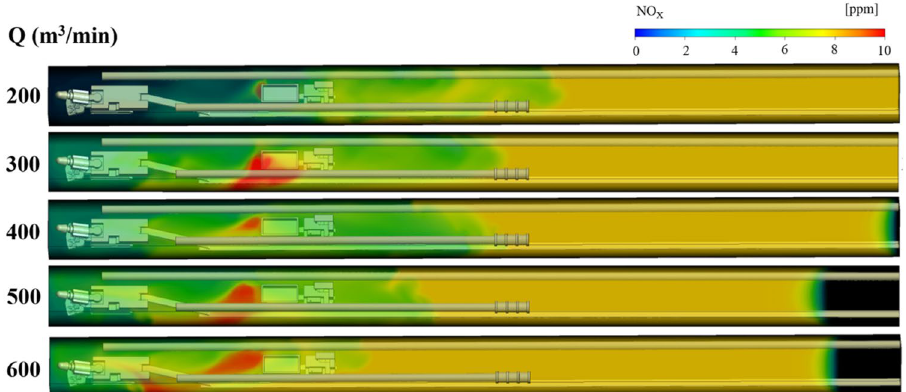
Figure 7. NO x gas distribution under different air volumes Q at L = 20 m.